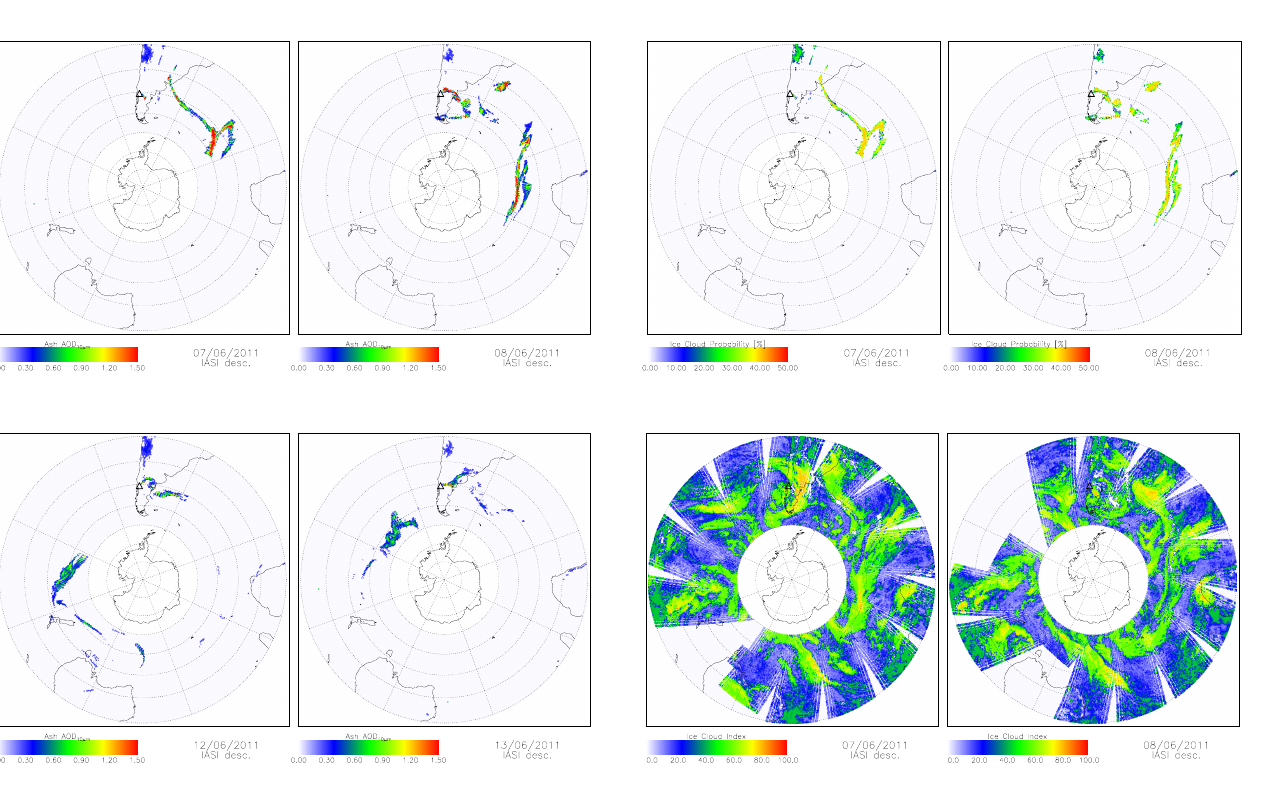
Fig. 3. The PCCE ash plume on its way around the Southern Hemi- sphere for descending MetOp orbits from 7, 8, 12 and 13 June.